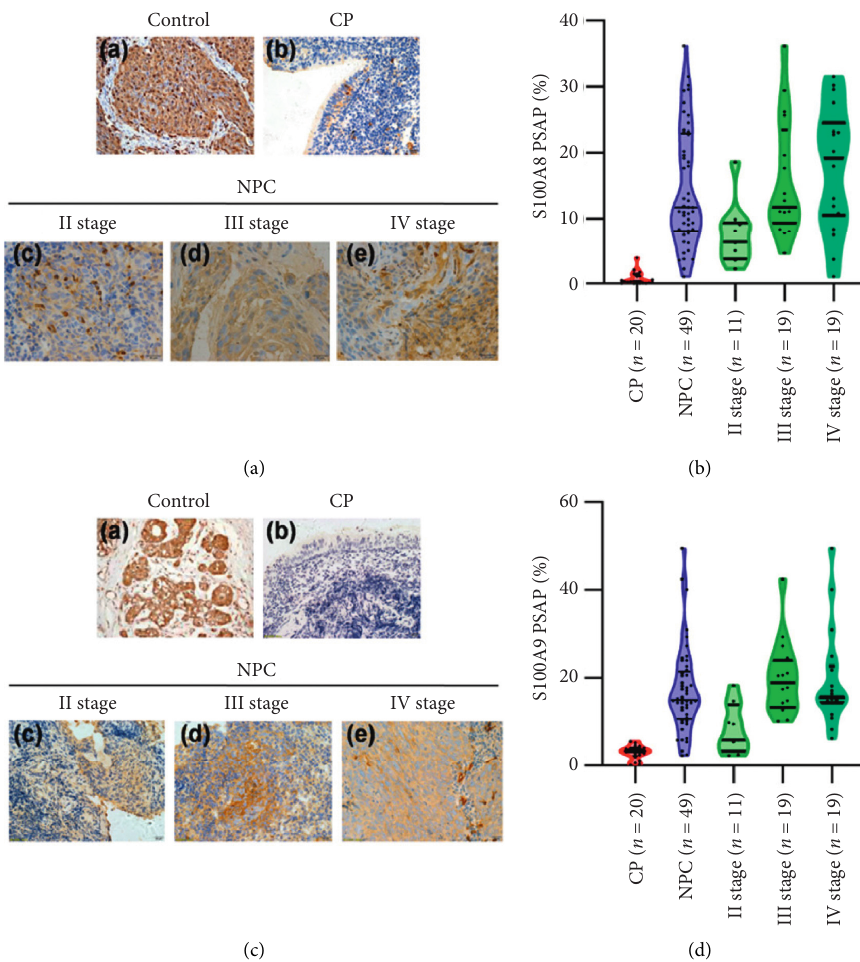
Figure 1: S100A8 and S100A9 expressions in NPC and CP tissues detected by the immunohistochemistry method. (a) Representative images of S100A8 expression (brown-yellow or tan staining) in positive control (a) (human cervical carcinoma tissue provided by Abcam), CP tissue (b), or NPC tissues in stage II (c), III (d), and IV (e) (magnification 200 × ). (b) Violin plot of S100A8 positive staining area percentage (PSAP) for CP and NPC tissues including stage II, III, and IV. (c) Representative images of S100A9 expression (brown-yellow or tan staining) in positive control (a) (human spleen tissue provided by Abcam), CP tissue (b), or NPC tissues in stage II (c), III (d), and IV (e) (magnification 200 × ). (d) Violin plot of S100A8 positive staining area percentage (PSAP) for CP and NPC tissues including stages II, III, and IV. CP, chronic pharyngitis; NPC, nasopharyngeal